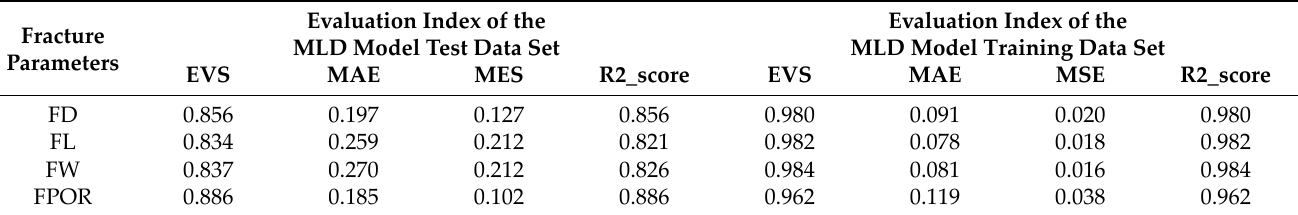
Table 2. Training results of the MLP